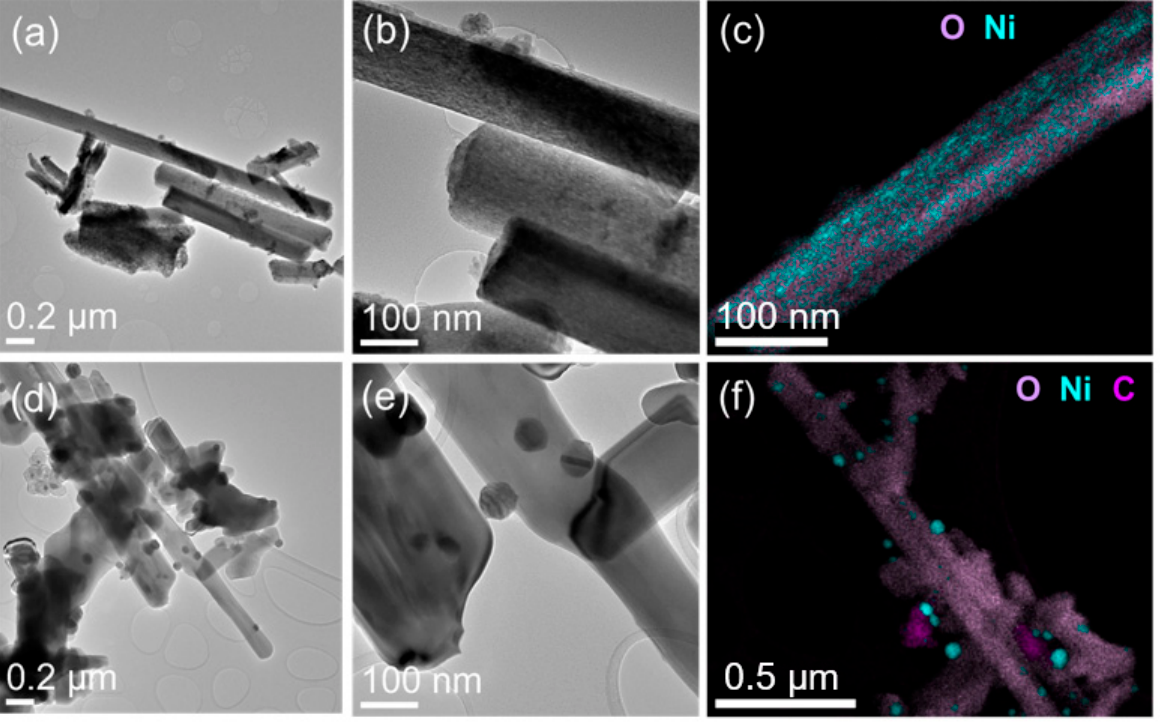
Figure 6. ( a , d ) Low- and ( b , e ) high-magnification TEM images and ( c , f ) EDS elemental maps of fresh and spent nanowire catalyst sample.